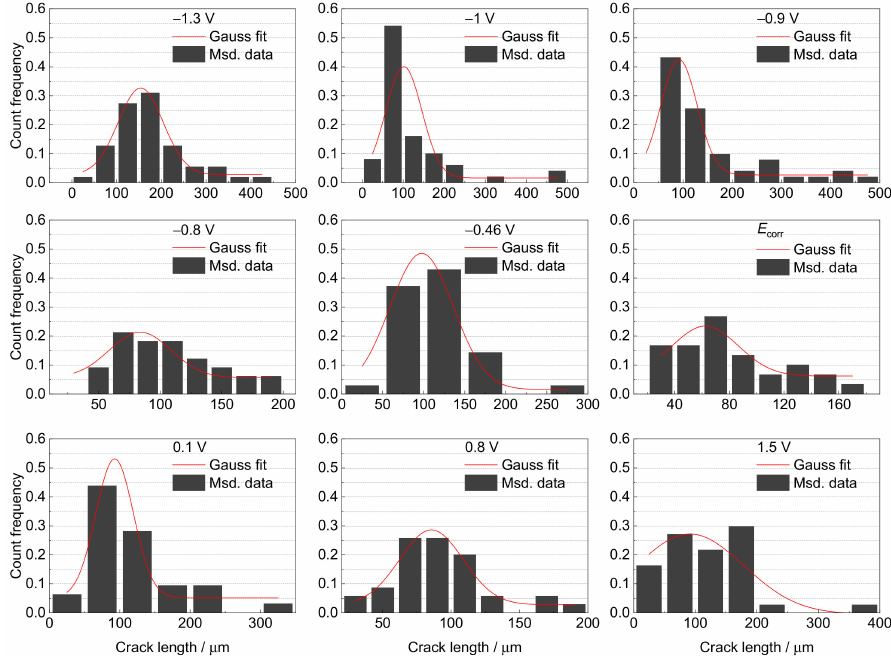
Figure 12. The distribution of secondary crack length near the main crack at various potentials in a simulated deep–sea environment.